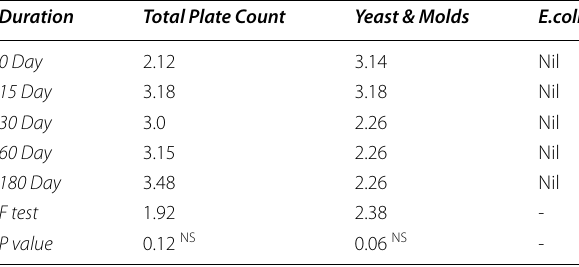
Table 8 Microbial Count (Log Gummies Stored for a period of 6 months (37